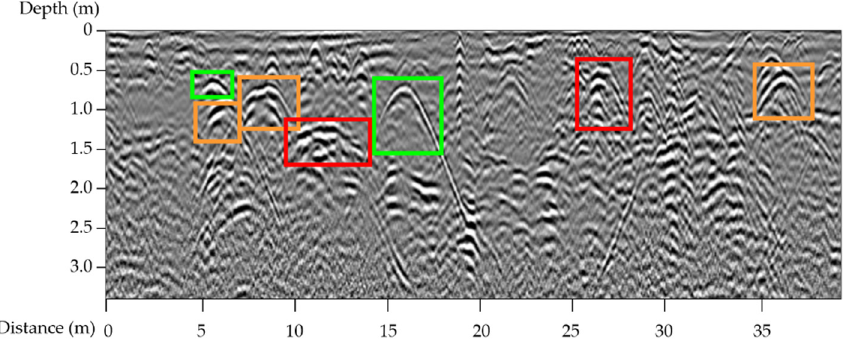
Figure 4. Manual classification of candidate objects.